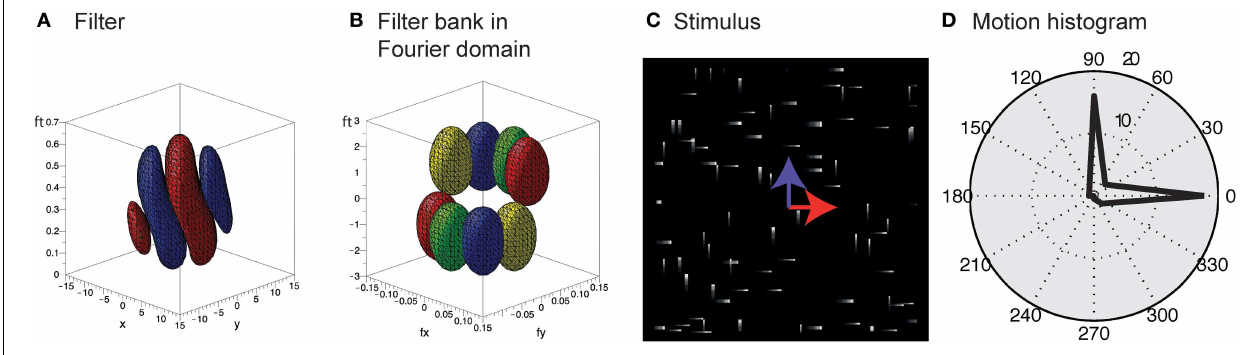
FIGURE 10 | Encoding of motion transparency in the proposed spectrum of the filter shown in (A) ]. Note that the combined ellipsoids model. (A) Illustration of a single spatio-temporal filter (surfaces indicate sample the frequency space, with each pair responding to a certain that F speed and motion direction. (C) Stimulus consisting of a random dot 0 . 0005 for red/blue). Note that this filter resembles = ± measurements of, for example, the cat’s striate cortex (e.g., pattern of dots moving to the right or to the top with equal speeds. DeAngelis et al., 1995, Their Figure 2B). (B) Illustration of the preferred (D) Motion histogram of filter responses. While it is not possible to fit a frequencies (surfaces indicate that plane to the resulting event cloud, the proposed filter based approach F 0 . 1 ) of four filters of a filter | ˆ | = bank in the Fourier domain [red pair of ellipsoids corresponds to Fourier encodes both movement